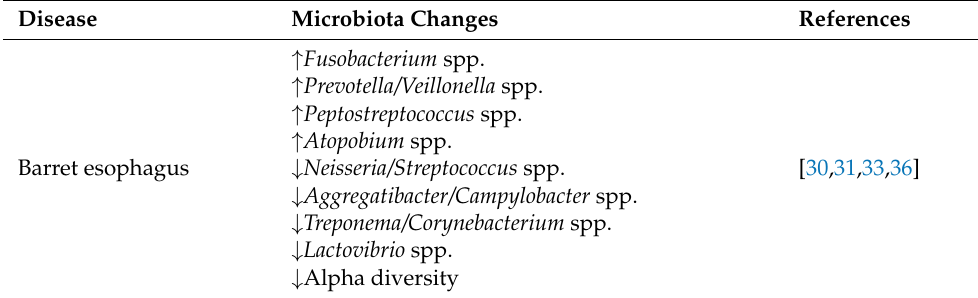
Table 1. Microbiota changes in digestive disorders.